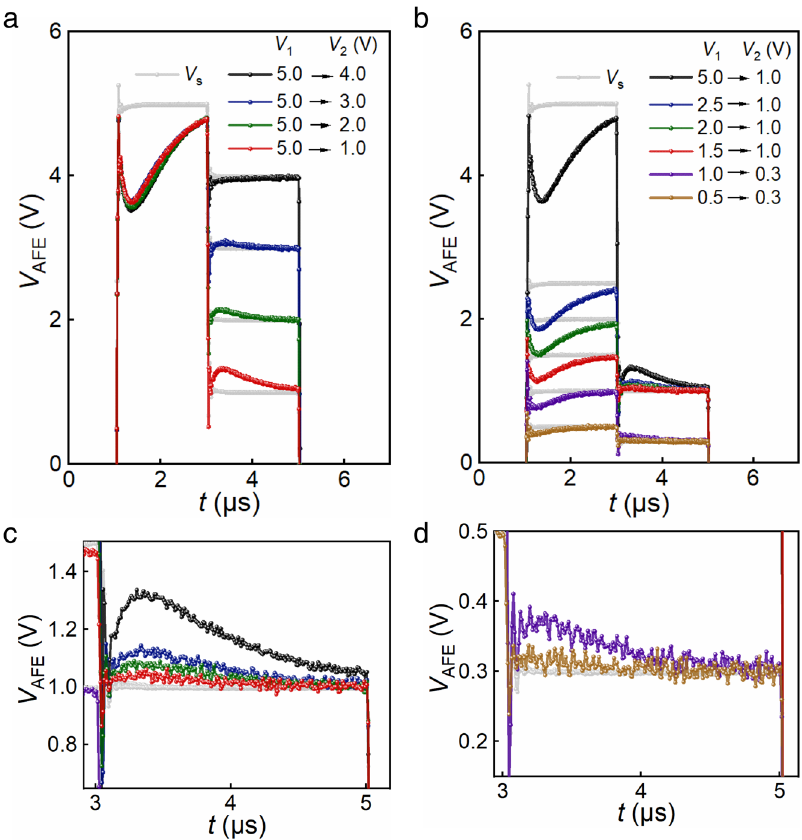
Fig. 5 V AFE transients under different magnitudes of applied voltages. a Transient response of source voltage V s with the same V 1 of 5.0 V and different V 2 , and the corresponding voltage across the antiferroelectric capacitor 0.3 V, and the corresponding voltage V AFE . The second NC effect in b is magni fi ed in c and d . The gray lines represent the source voltage V s with two different amplitudes of V 1 and V 2 , and the colored lines represent the transient voltage response under V s